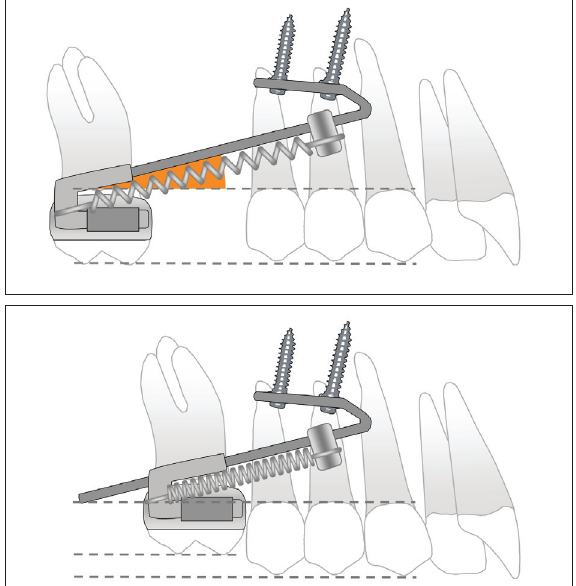
Figure 5. Principle of simultaneous intrusion and mesialisation of upper second